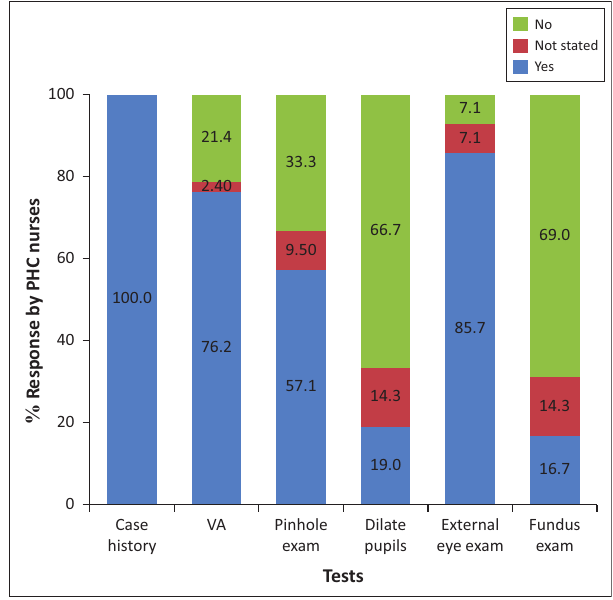
FIGURE 3: The self-estimated (in percentages) role of primary healthcare nurses in conducting ocular